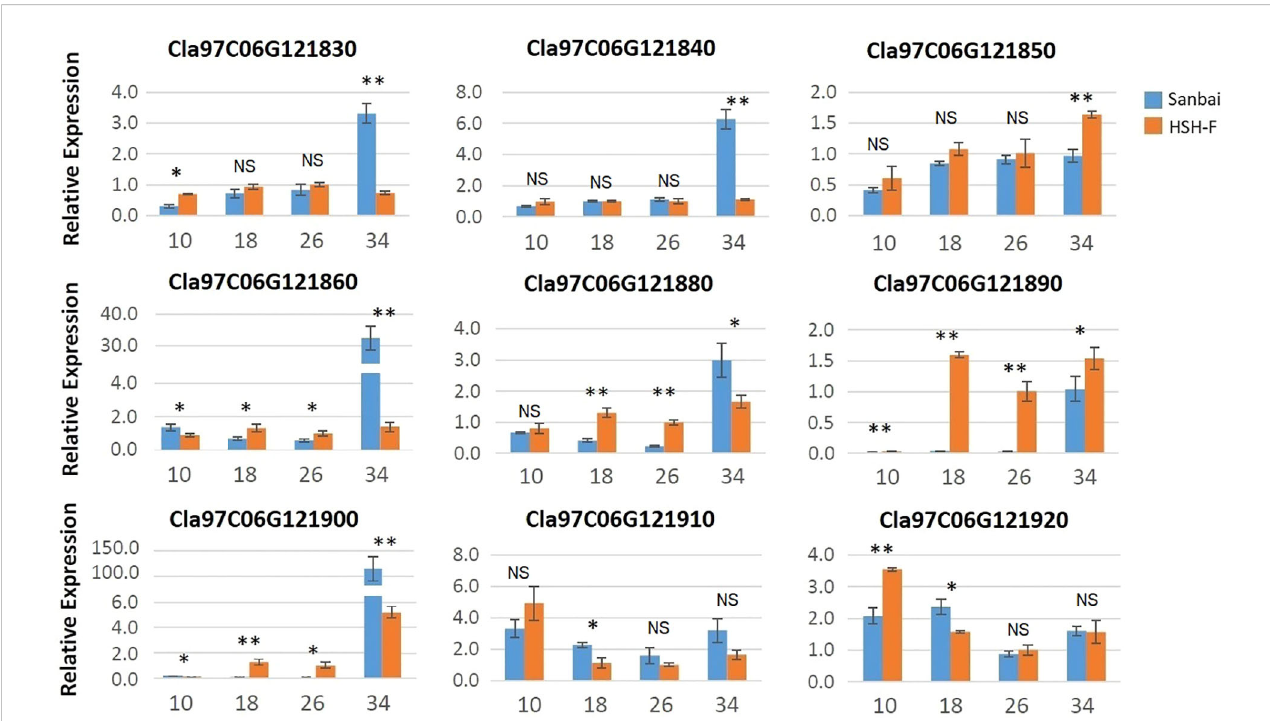
FIGURE 4 Relative expression of the candidate genes in fruits at different developmental stages of HSH-F and Sanbai. Numbers on the x -axis — 10, 18, 26, and 34 — represent fruits at 10, 18, 26, and 34 days after pollination (DAP), respectively. Error bars indicate the mean ± SD ( n = 3). Signi fi cant difference between the two parents at each stage was assessed using Student ’ s t -test. * p < 0.05; ** p < 0.01. NS, no signi fi cance.